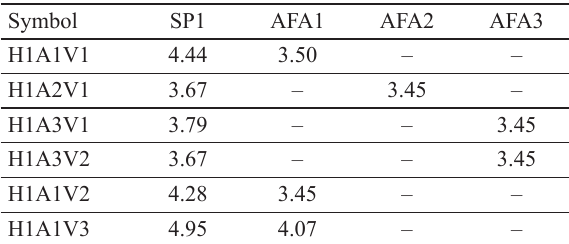
Table 8. The dosage of SP and AFA by weight of total binder, %